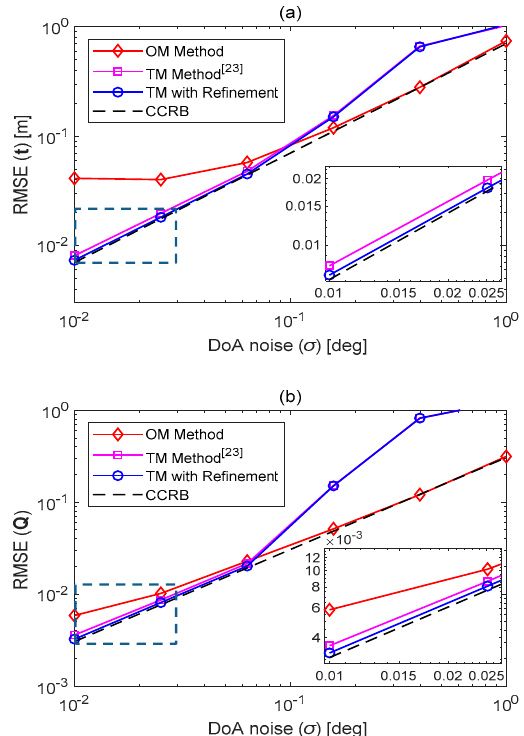
Figure 4. Comparison of RMSEs of ( a ) the estimated translation vector and ( b ) the estimated rotation matrix, when 𝐷 = 1.5 m.